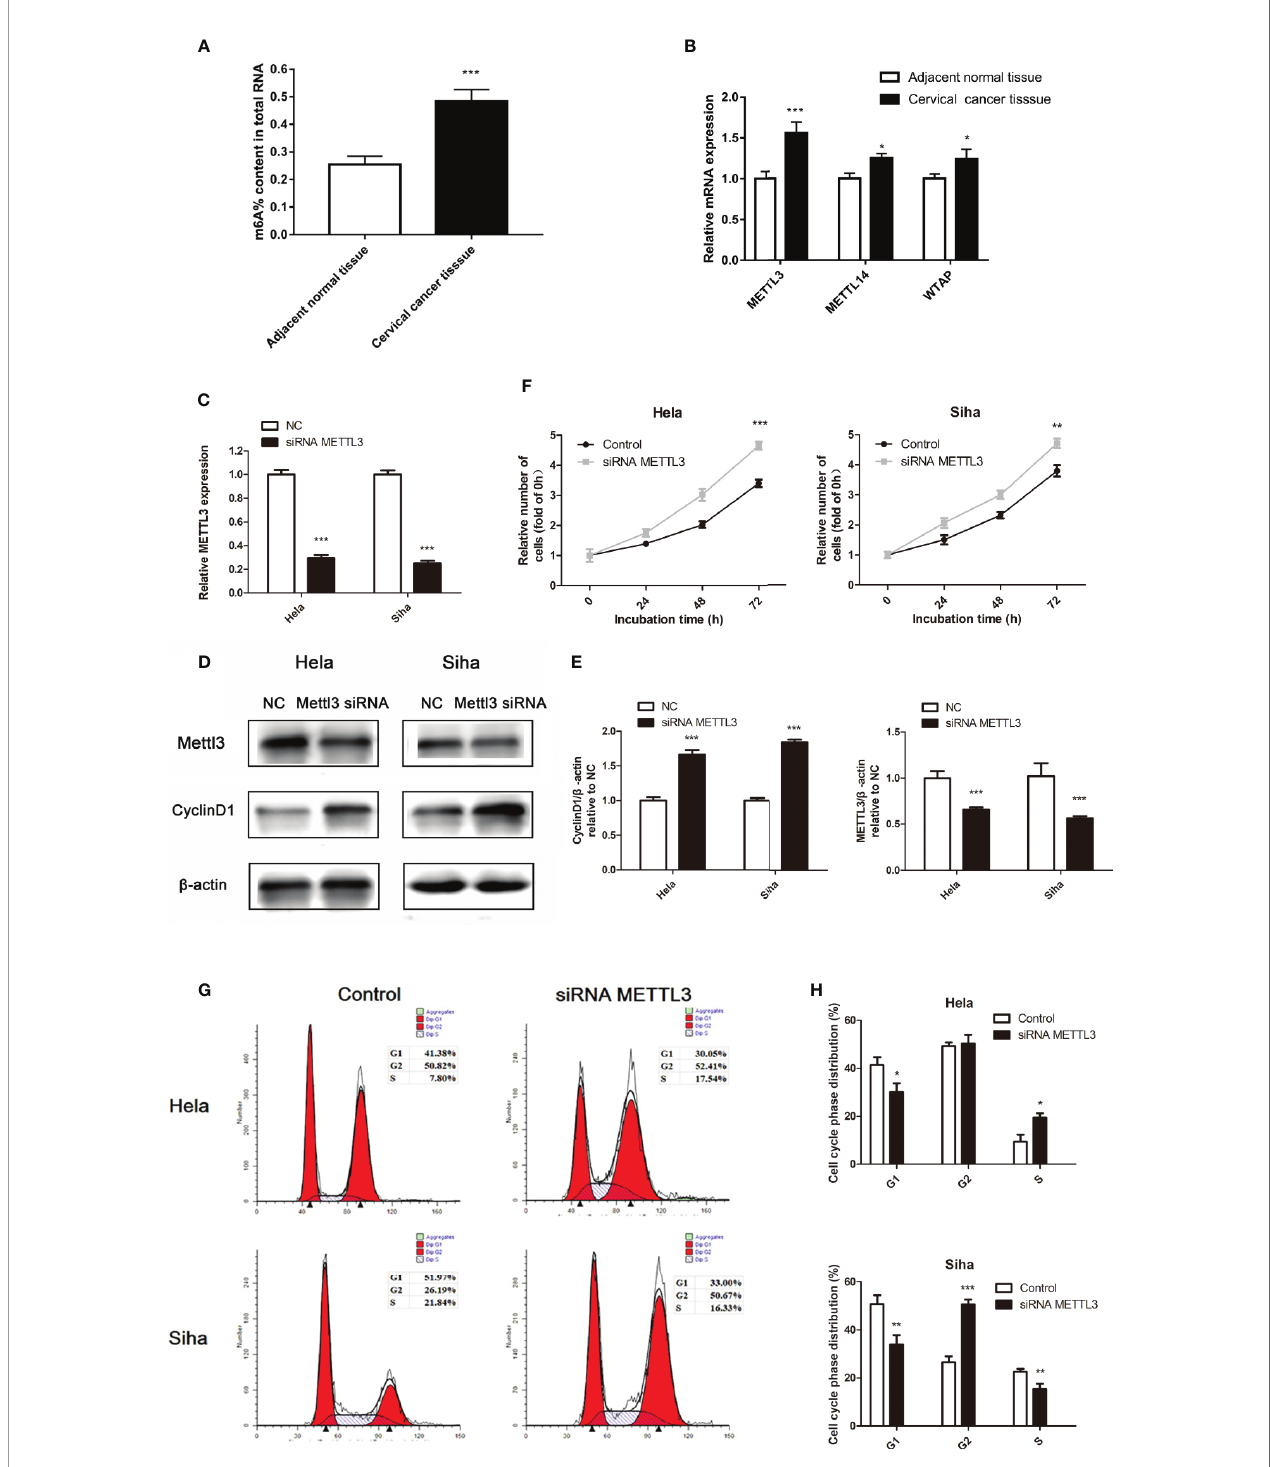
FIGURE 4 | m 6 A methylation in cervical cancer. (A) The total m 6 A methylation level in cervical cancer tissues and adjacent normal tissues. (B) mRNA expression of METTL3, METTL14, and WTAP were measured by qRT-PCR. (C – E) Hela and Siha cells were transfected with siRNA METTL3 or negative control. METTL3 mRNA level (C) , METTL3, and CCND1 protein level (D) were detected after transfected. (E) Band density of Western blot was quanti fi ed using ImageJ, and protein levels were normalized to b -actin. (F) Cellular proliferation was assessed using CCK-8 assays. (G) Flow cytometry was used to assess distributions of cells across the cell cycle. (H) The quali fi cations of the cell cycle were presented. * p < 0.05, ** p < 0.01, *** p <